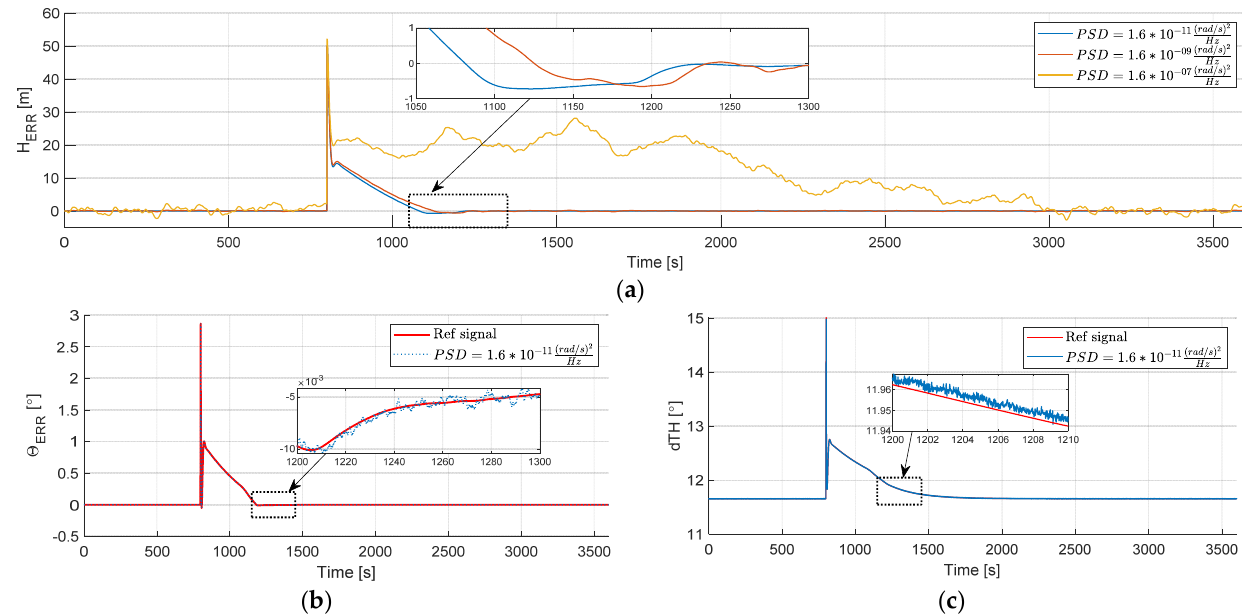
Figure 8. Influence of white noise on elimination of altitude error: ( a ) Comparison of altitude error; ( b ) Comparison of pitch angle error; ( c ) Comparison of elevator trimmer deflection.